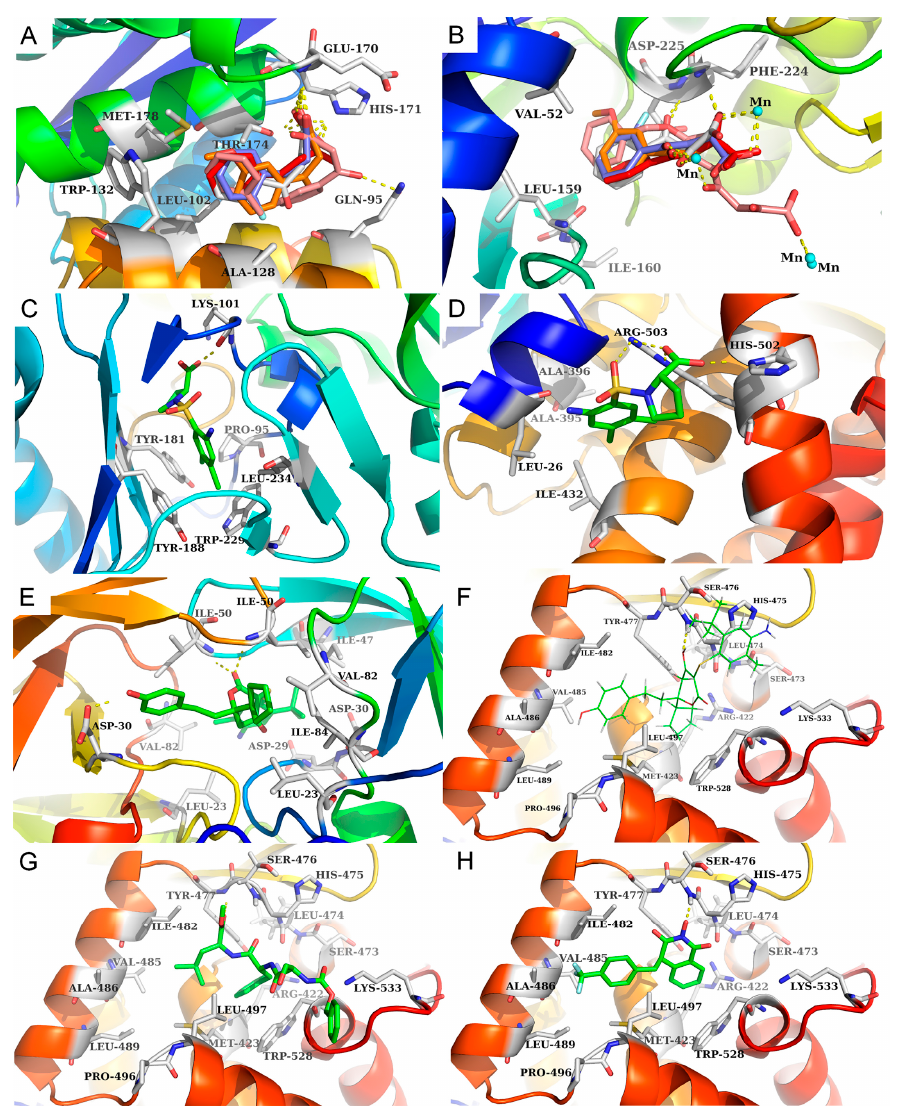
Figure 9. The binding modes of nine compounds in their respective binding sites. ( A , B ) show the binding modes of five compounds with HIV-1 IN (PDB: 4NYF) and HCV NS5B (PDB: 1GX6), respectively, including CHEMBL16326 (red), CHEMBL18927 (pink), CHEMBL449221 (purple), CHEMBL502238 (orange) and CHEMBL19332 (gray). ( C , D ) show the binding modes of CHEMBL210593 with HIV-1 RT (PDB: 1TL3) and HCV NS5B (PDB: 1OS5). ( E , F ) show the binding modes of CHEMBL37541 with HIV-1 PR (PDB: 4MC1) and HCV NS5B (PDB: 1OS5). ( G , H ) show the binding modes of two compounds (CHEMBL3612421 and CHEMBL1668670) with HCV NS5B (PDB 1OS5). (The cocrystallized molecules are shown as lines, whereas the molecules modeled into the receptors are shown as